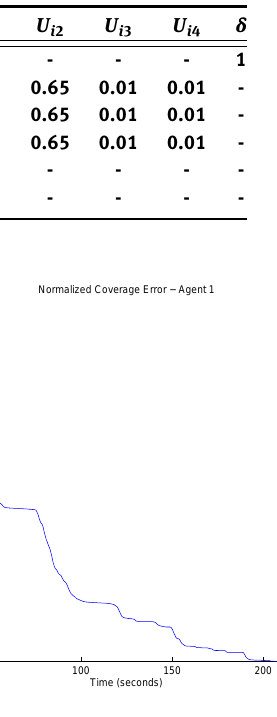
Fig. 5. Coverage error in time according to robot